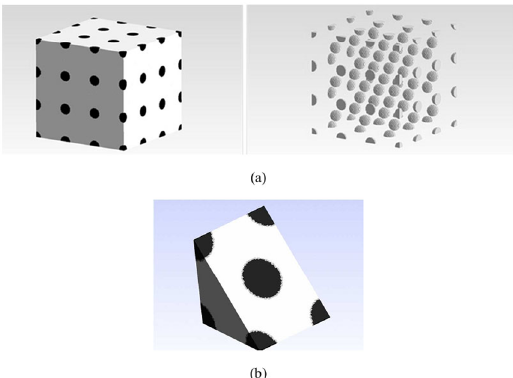
and the mesh density was obtained with a proper convergence analysis. Figure 6 (a) shows one of the Finite Element Models used in the simulations. The geometric distribution of the Epoxy reinforcements has little to no impact (max 2%) in the effective value of the Young’s modulus, for the range of volume fractions studied in this work. The only (small) influence is in the symmetry of the constitutive tensor, since for a random distribution one obtains an isotropic tensor, whereas a regular distribution results in a cubic tensor. Since the experimental value used for comparison is the Young’s modulus, it is not possible to assess the anisotropy of the